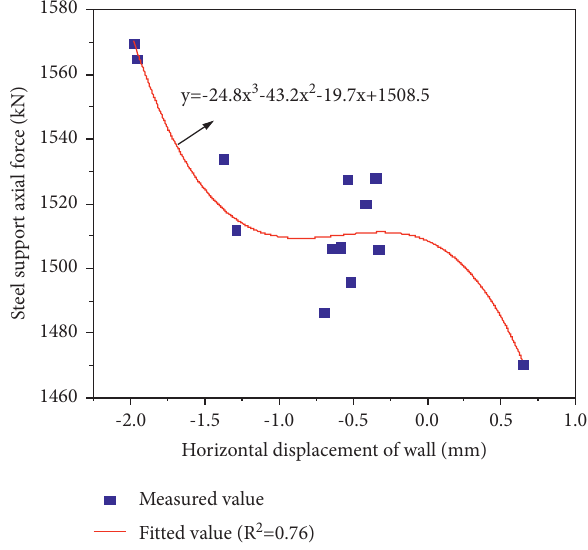
Figure 21: The relationship between wall displacement and steel support axial